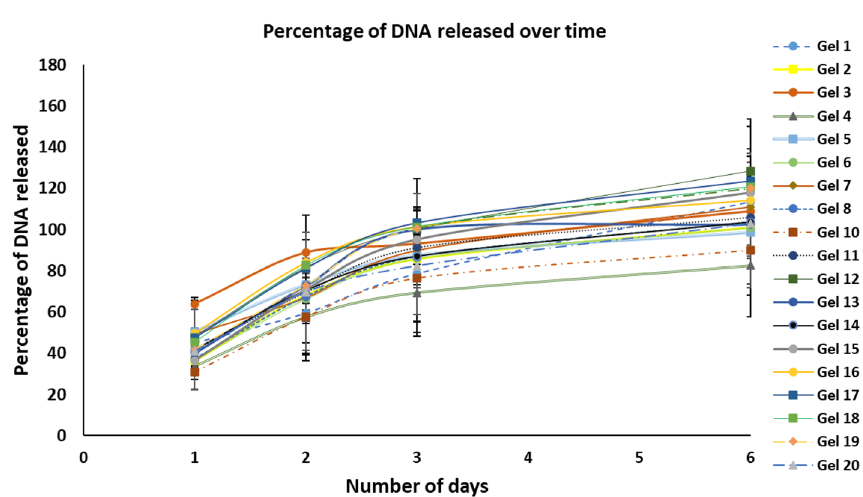
Figure 5. Percentage of DNA released over time. Hydrogels were prepared using different concentrations of thrombin, aprotinin and DNA (concentrations are indicated in Table 2). The percentage of DNA released was measured at different timepoints. DNA was completely released after 6 days, and a similar pattern was observed for all groups. N =